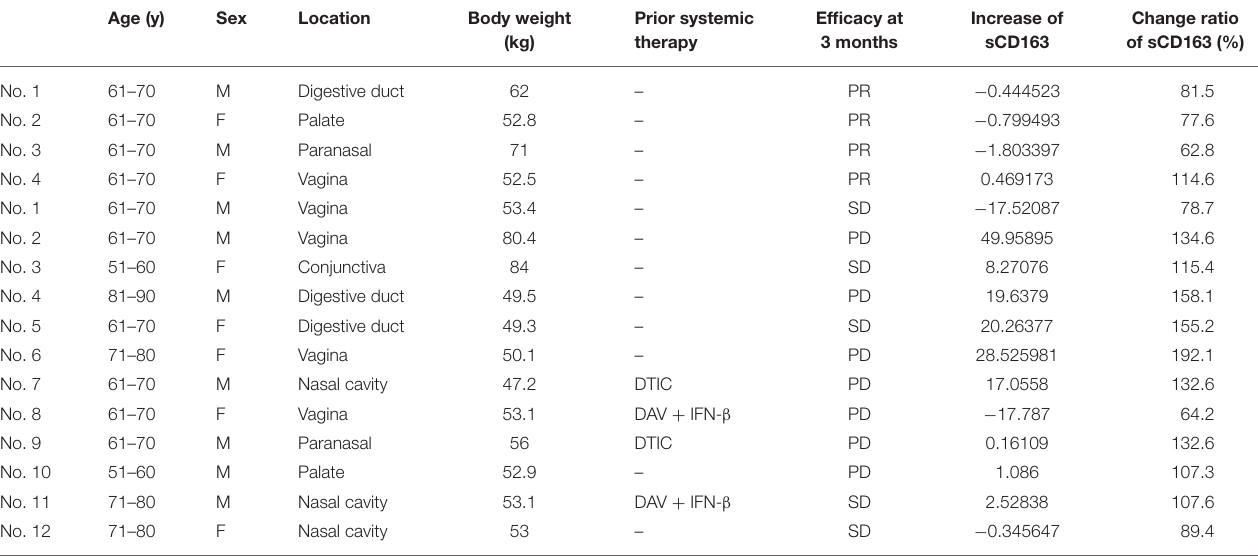
TABLE 2 | Characteristics and serum levels of sCD163 in patients with non-cutaneous melanoma. Age